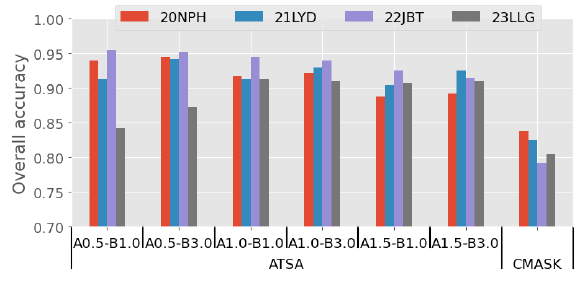
Figure 3 Overall accuracy for CMASK and different combinations of A and B parameters in ATSA algorithms considering two classes: Clear and No clear.